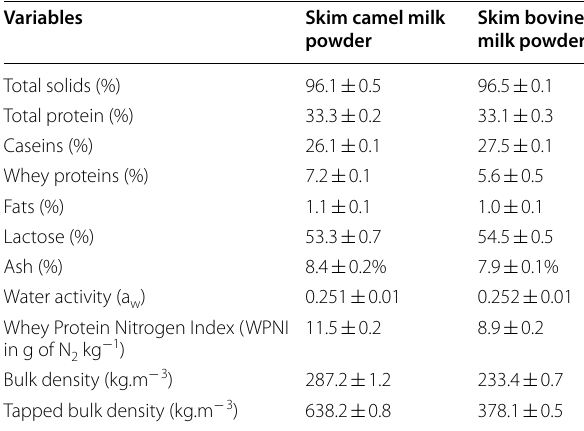
Table 3 Chemical and physical characteristics of skim camel milk powder in comparison with skim bovine milk powder (Zouari, Briard-Bion, et al.